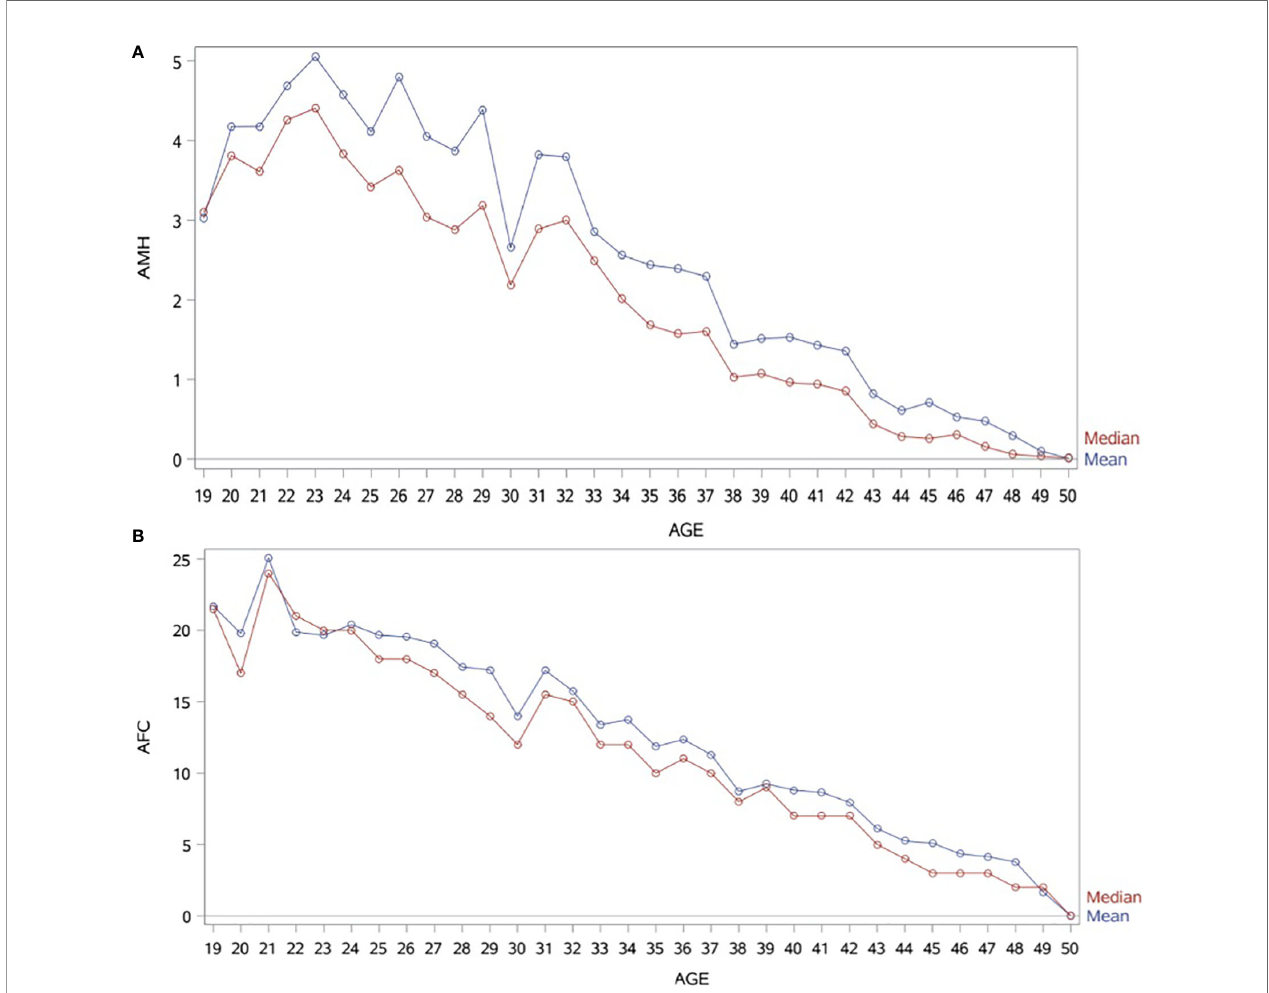
FIGURE 2 | (A) Graphical comparisons of AMH mean and median in 1-year intervals. AMH (ng/mL). (B) Graphical comparisons of AFC mean and median in 1-year intervals.